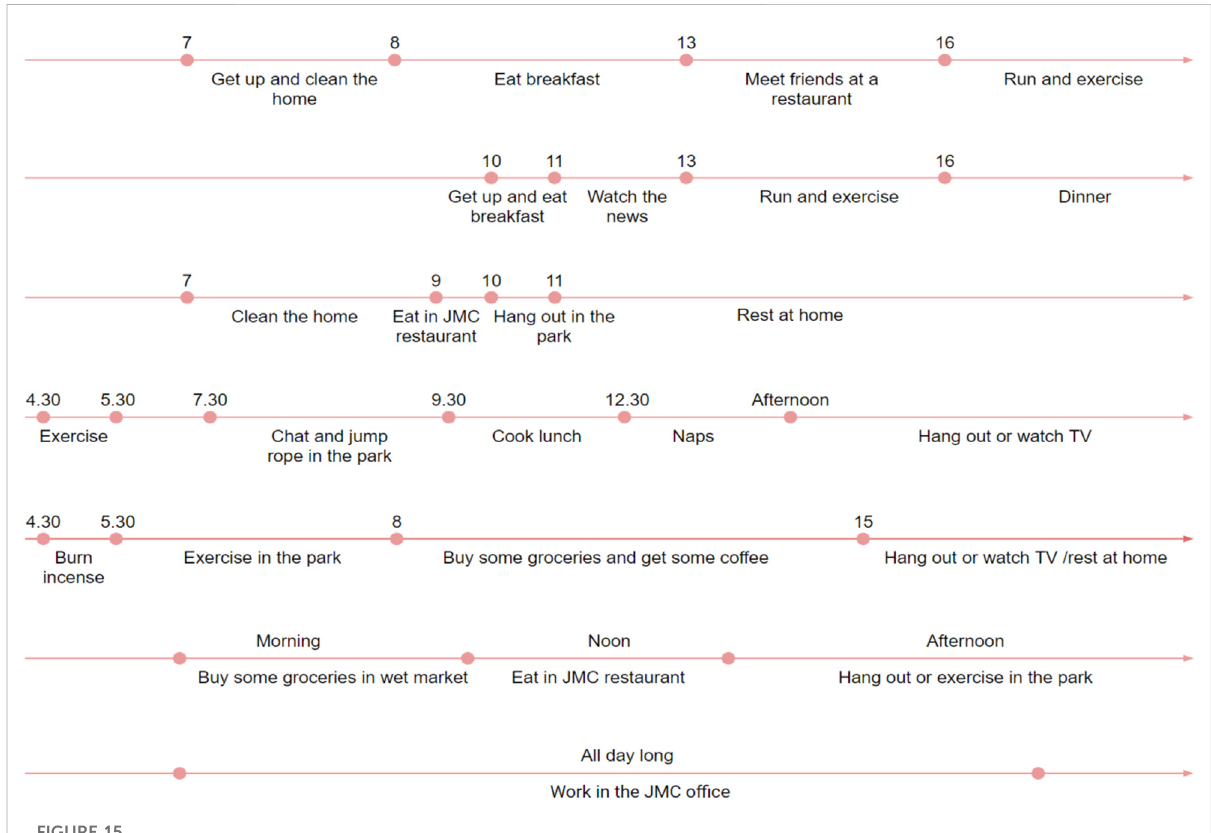
FIGURE 15 User journey maps fi lled by seven residents before